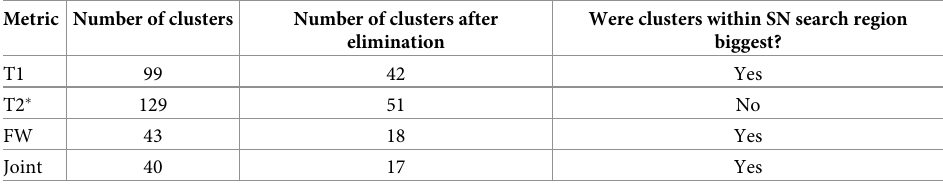
Table 3. Summary of detected clusters of voxels in the whole